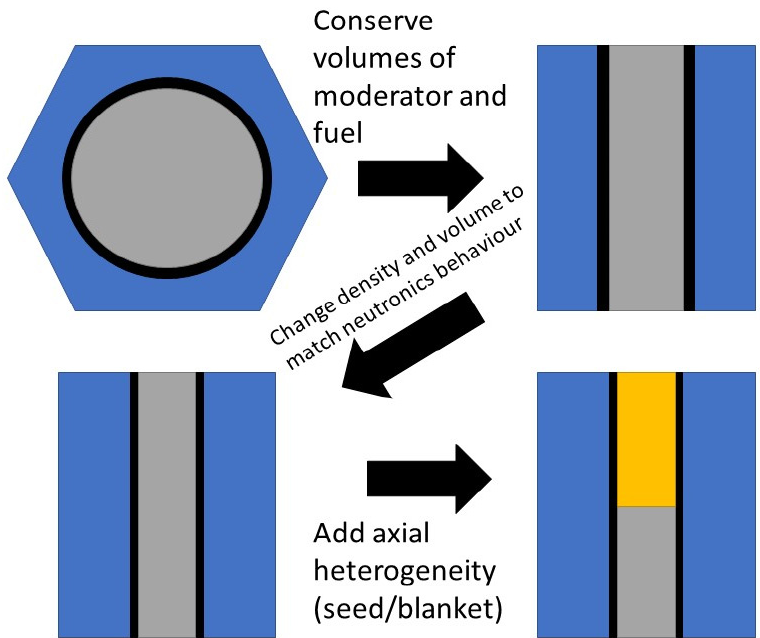
Figure 5. Simple diagrammatic representation of the processes undertaken as part of this work.